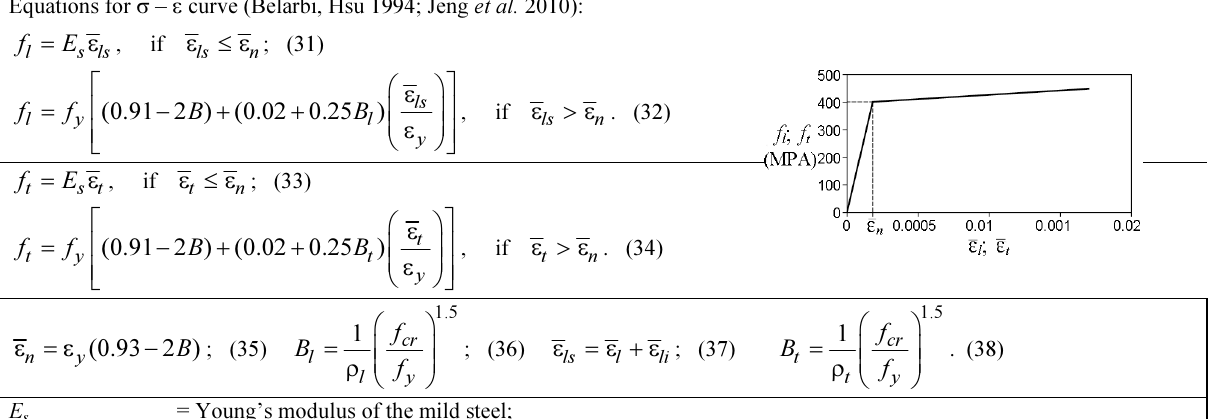
Table 4. σ – ε relationship for mild steel for PC beams (for RC beams: 0 li ε =